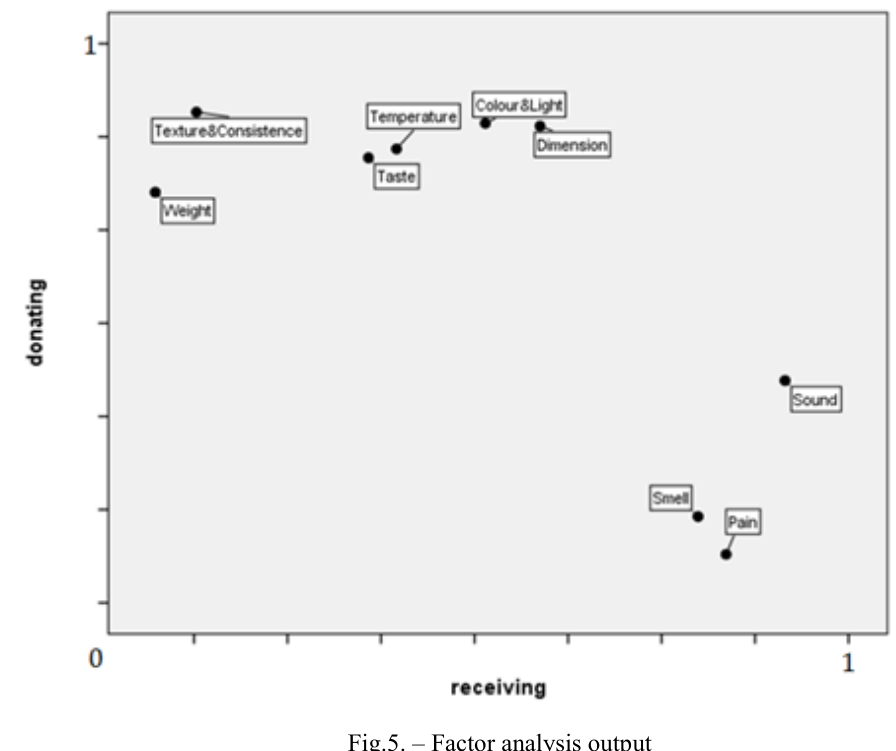
Fig.5. – Factor analysis